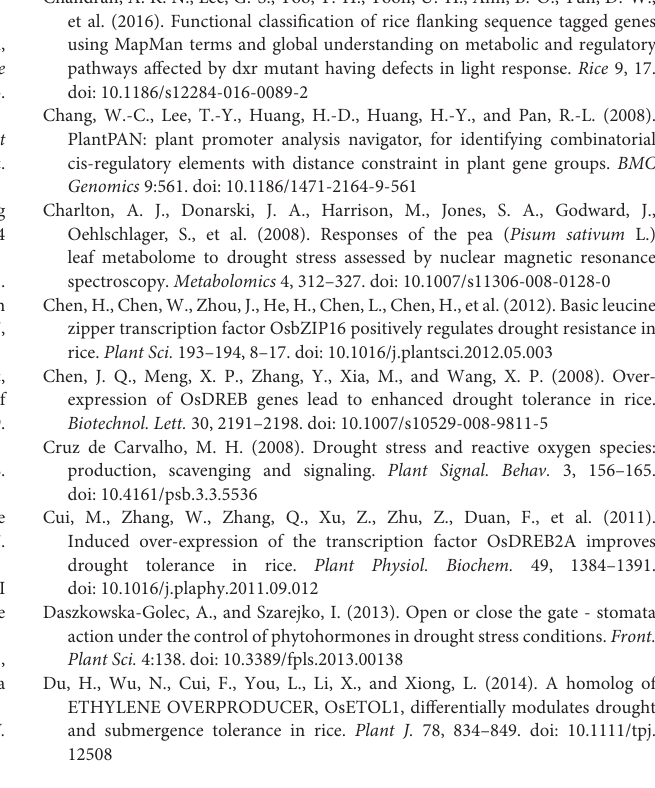
Figure S1 | Number of upregulated and downregulated genes identified from comparisons between roots of plants exposed for 2 or 3 d to WD treatment and corresponding well-watered controls. Figure S2 | Validation of two water deficiency-induced genes [ (A) ; LOC_Os04g52290 and (B) ; LOC_Os07g02710 ] revealed by promoter trap system and GUS